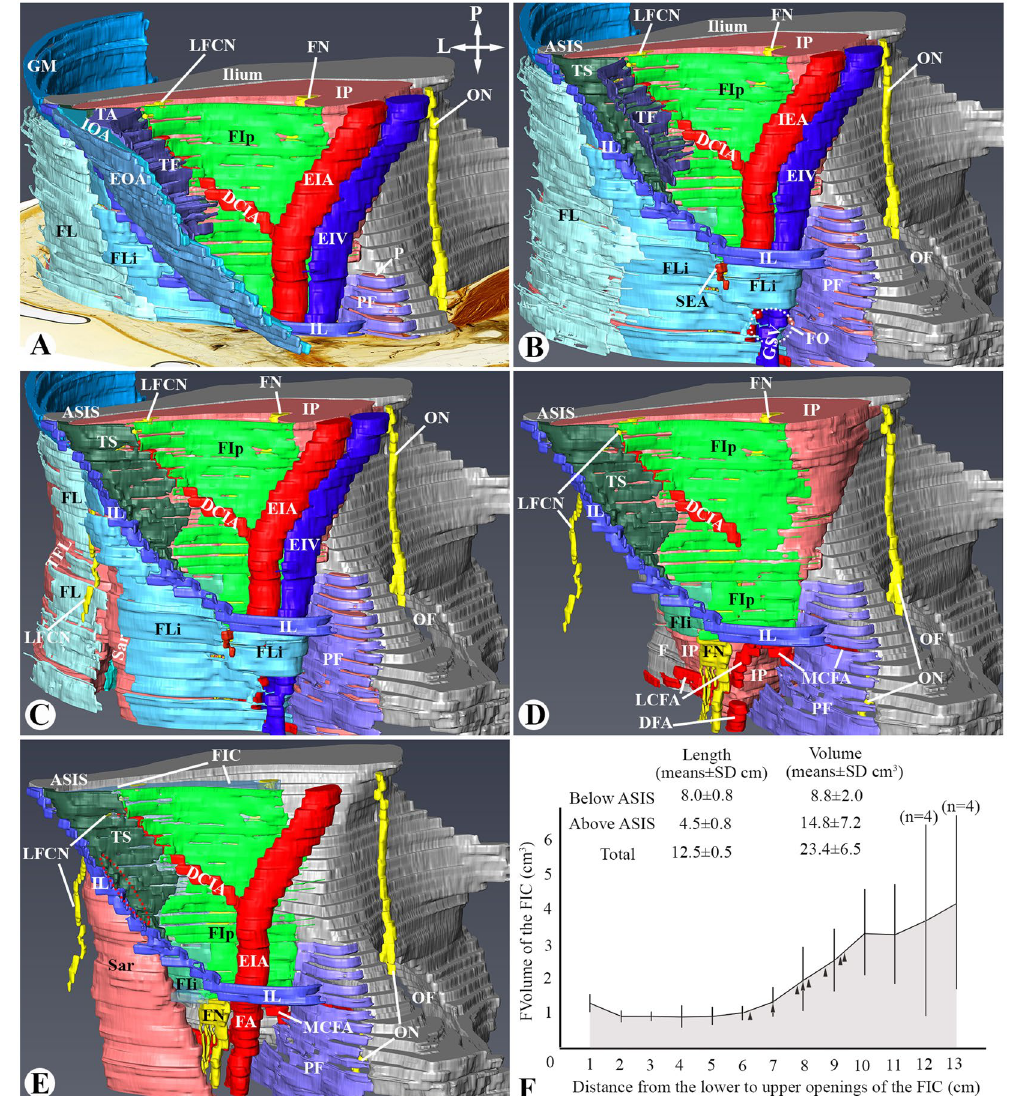
Figure 5. A three-dimensional (3D) image reconstructed from the plastinated sections showing the architecture of the fascia iliaca below the anterior superior iliac spine (ASIS). ( A ) The 3D image with a plastinated section. Crossed-arrows: orientation of the figure (L: lateral; P: posterior); DCIA: deep circumflex iliac artery; EIA/EIV: external iliac artery and vein; EOA: external oblique abdominis; FIp: psoas part of the fascia iliaca; FL: fascia lata; FLi: fascia lata formed by the inferior prolongation of the IL; FN: femoral nerve; GM: gluteal muscles; IL: inguinal ligament; IOA: internal oblique abdominis; IP: iliopsoas muscle; LFCN: lateral femoral cutaneous nerve; ON: obturator nerve; P: pectineus muscle; PF: pectineal fascia; TA: transversus abdominis; TF: transversalis fascia. ( B ) The conjoint tendinous sheet (TS) is the anterior part of the fascia iliaca, inferior to the ASIS, anterior to the transversalis fascia (TF), and posterior to the IL. Dashed circle and FO: fossa ovalis; GSV: great saphenous vein; SEA: superficial epigastric artery. See Supplemental Digital Content 1 for a 3D view of ( B) . ( C ) The lateral part of the FL is partially removed to expose the LFCN which pierces the TS and runs under the IL. Sar: sartorius; TEL: tensor fascia lata. ( D ) The fascia iliaca consists of three parts - FIp, TS and FIi, and pierced by the FN and LFCN below the IL. DFA: deep femoral artery; F: femur; LCFA: lateral circumflex femoral artery. ( E ) An optimal needle placement (dashed circle) for the ultrasound-guided FIC block is through the TS at the site inferior to the ASIS and medial to the upper attachment of the sartorius (Sar). See Supplemental Digital Content 2 for a 3D view of ( E) without bones. ( F ) The average length and volume of the FIC estimated in the plastinated slices from 8 sides of 4 cadavers. The arrowheads in the graph indicate the level of the ASIS in the individual